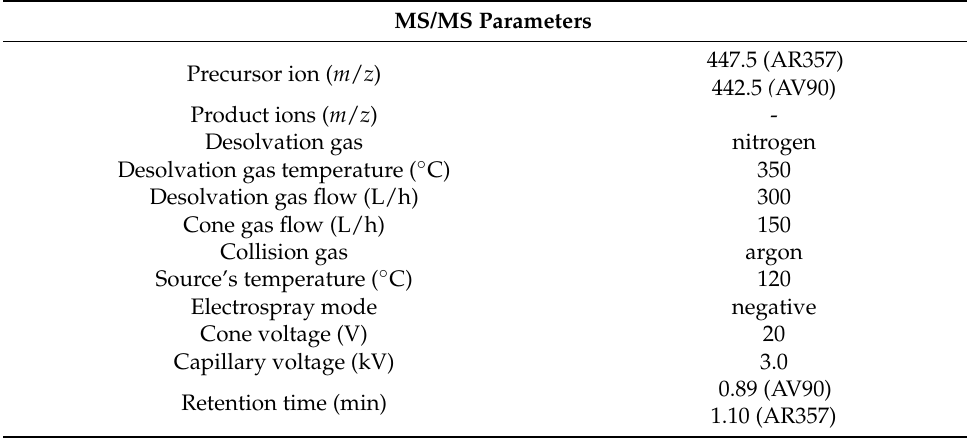
Table 4. Tandem mass spectrometry (MS/MS)